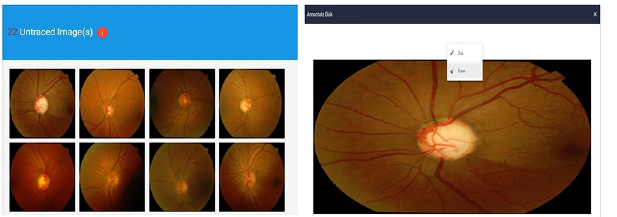
Fig 2. Web portal showing images assigned to the optometrists along with the pop up dialogue displayed once an image is pressed.